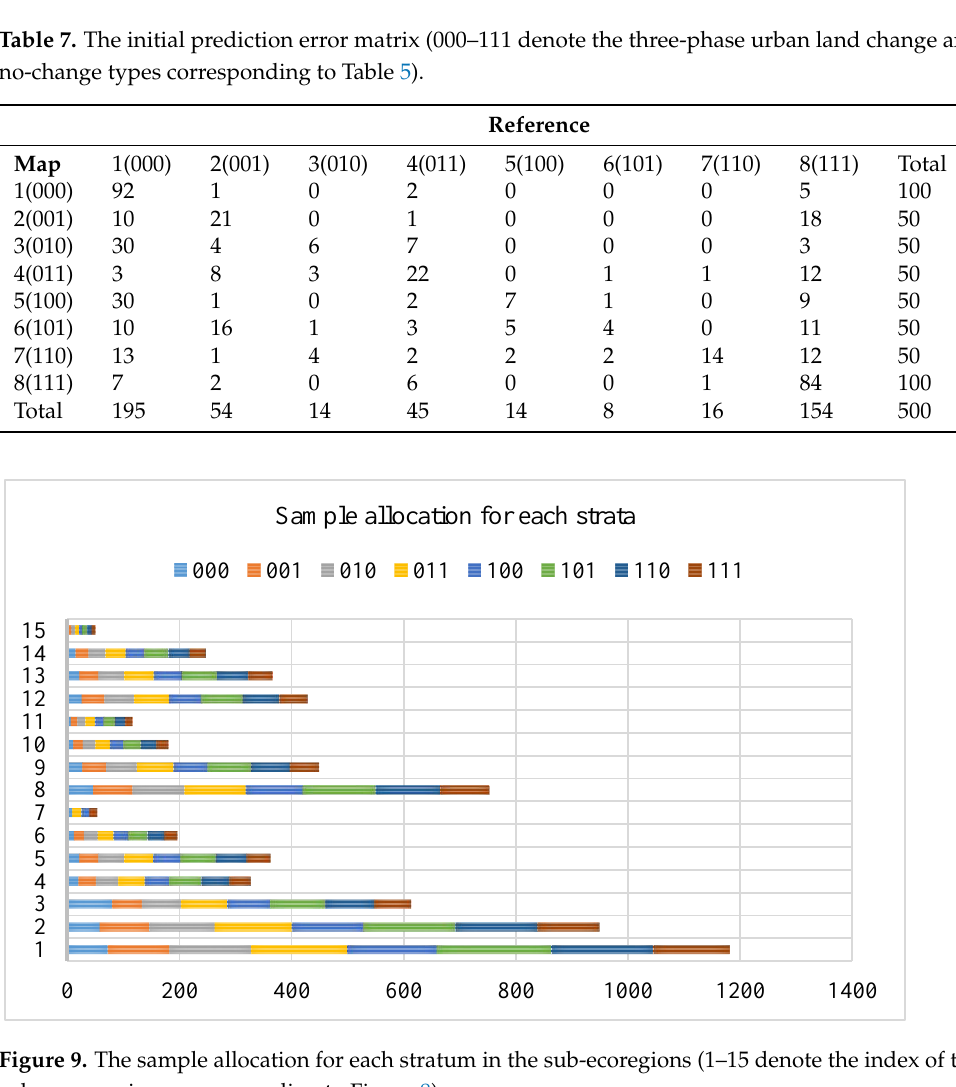
Figure 9. The sample allocation for each stratum in the sub-ecoregions (1 – 15 denote the index of the urban ecoregions corresponding to Figure 8).